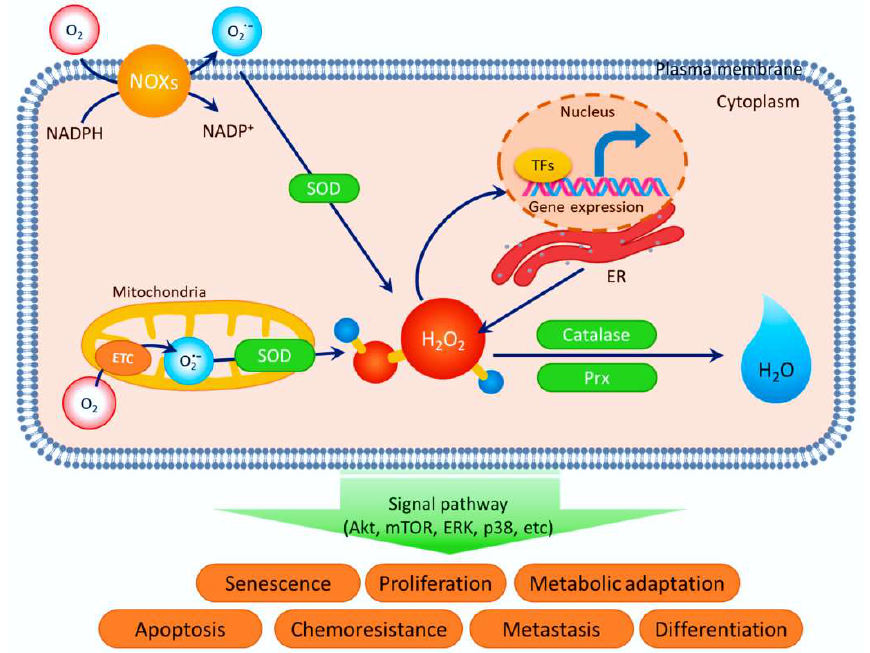
Figure 1. Redox homeostasis between generation and elimination of (ROS). Reproduced from the permission of ref. [81].